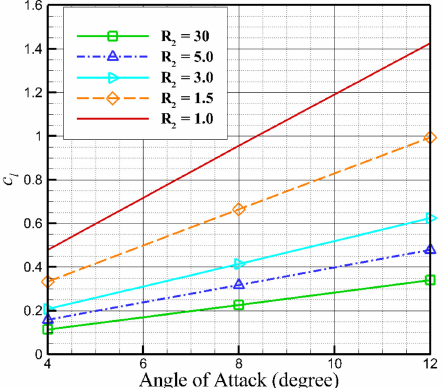
Figure 19. Lift coefficient with different velocity ratios.